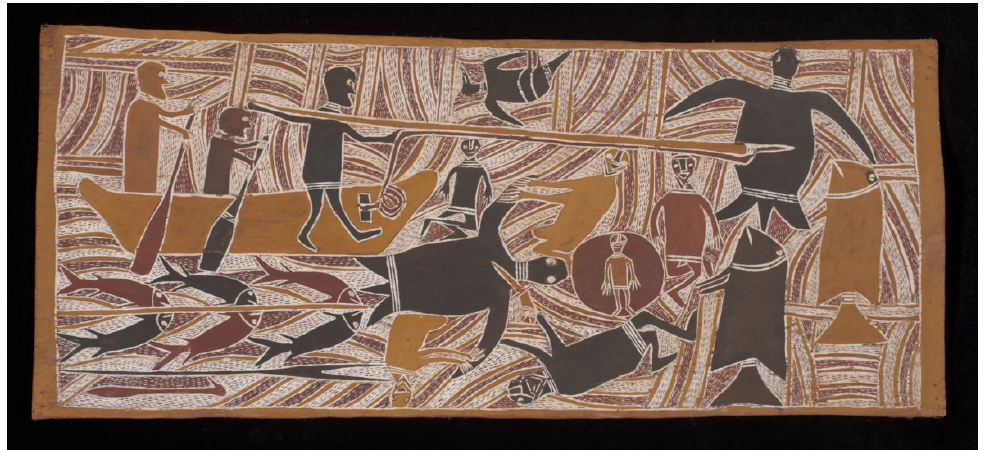
Figure 2 Mawalan Marika, ‘The Bremer Island Turtle Man’, 1967, 410 × 965 cm, ochre on eucalyptus bark, Groger ‐ Wurm collection, photography National Museum of Australia. Copyright Mawalan Marika/Aboriginal Artists Agency.